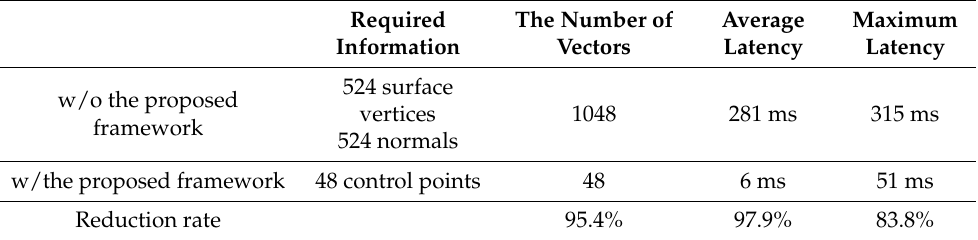
Table 1. Average and maximum latency comparison and reduction rate in the Stanford Bunny